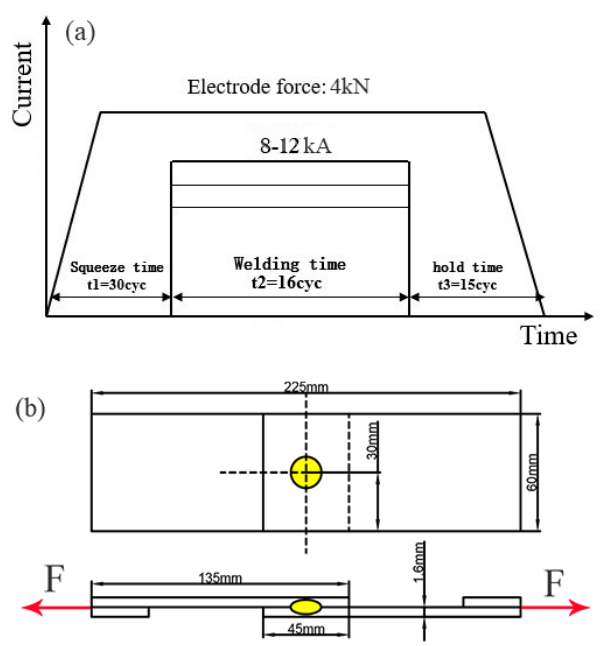
Figure 1. (a) Single-pulse welding process; (b) schematic diagram of weld microhardness test; (c) tension and shear